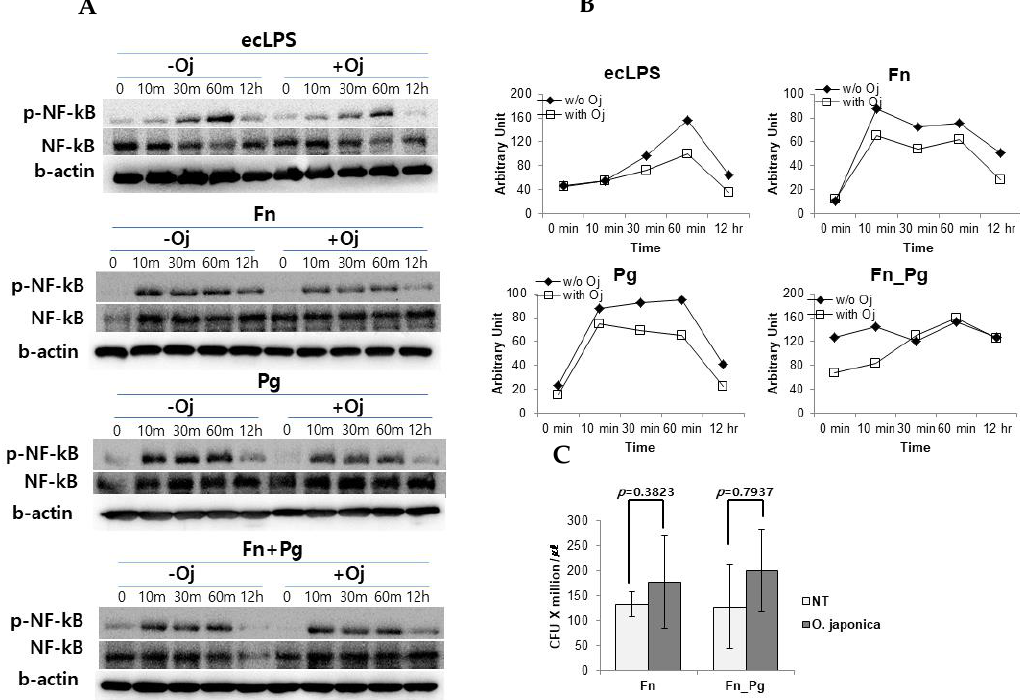
Figure 4. The e ff ect of OJE on NF- κ B phosphorylation and host cell invasion. ( A , B ) NF- κ B, phosphorylated NF- κ B (p-NF- κ B), and beta actin (b-actin) were blotted to detect and